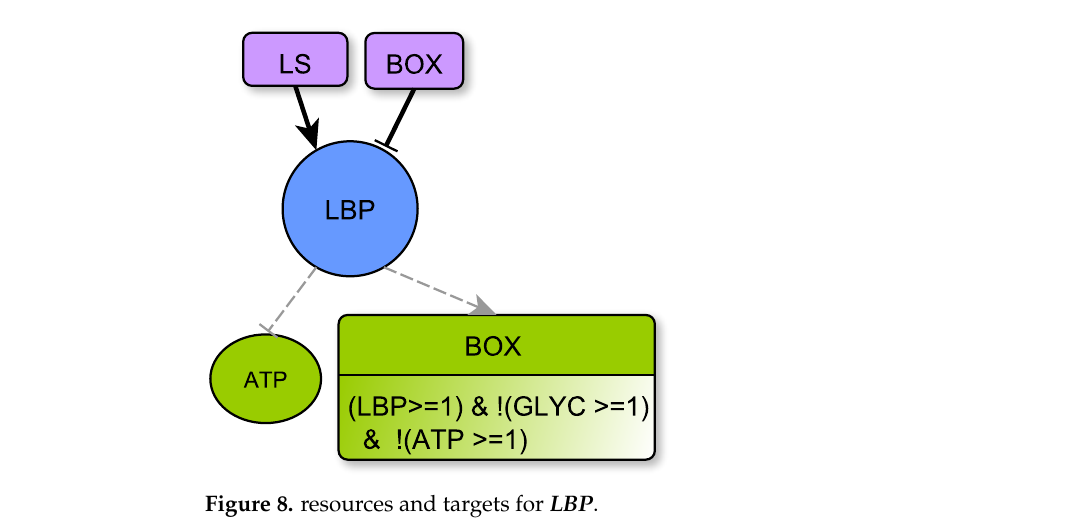
Figure 8. resources and targets for LBP